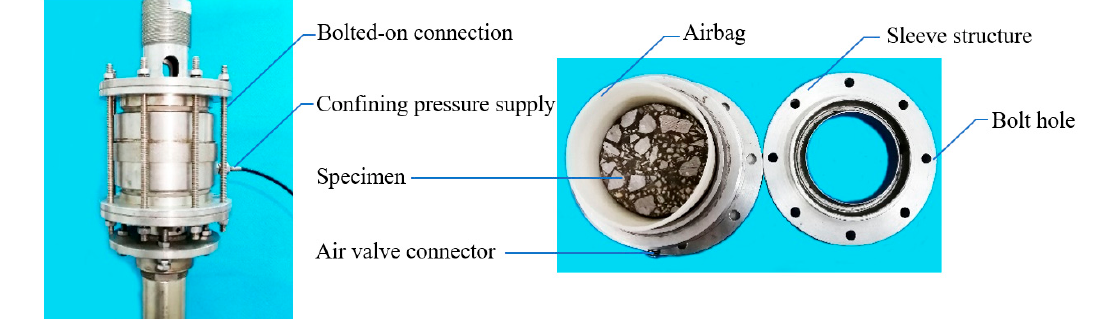
Figure 6. Strength test under various stress states.